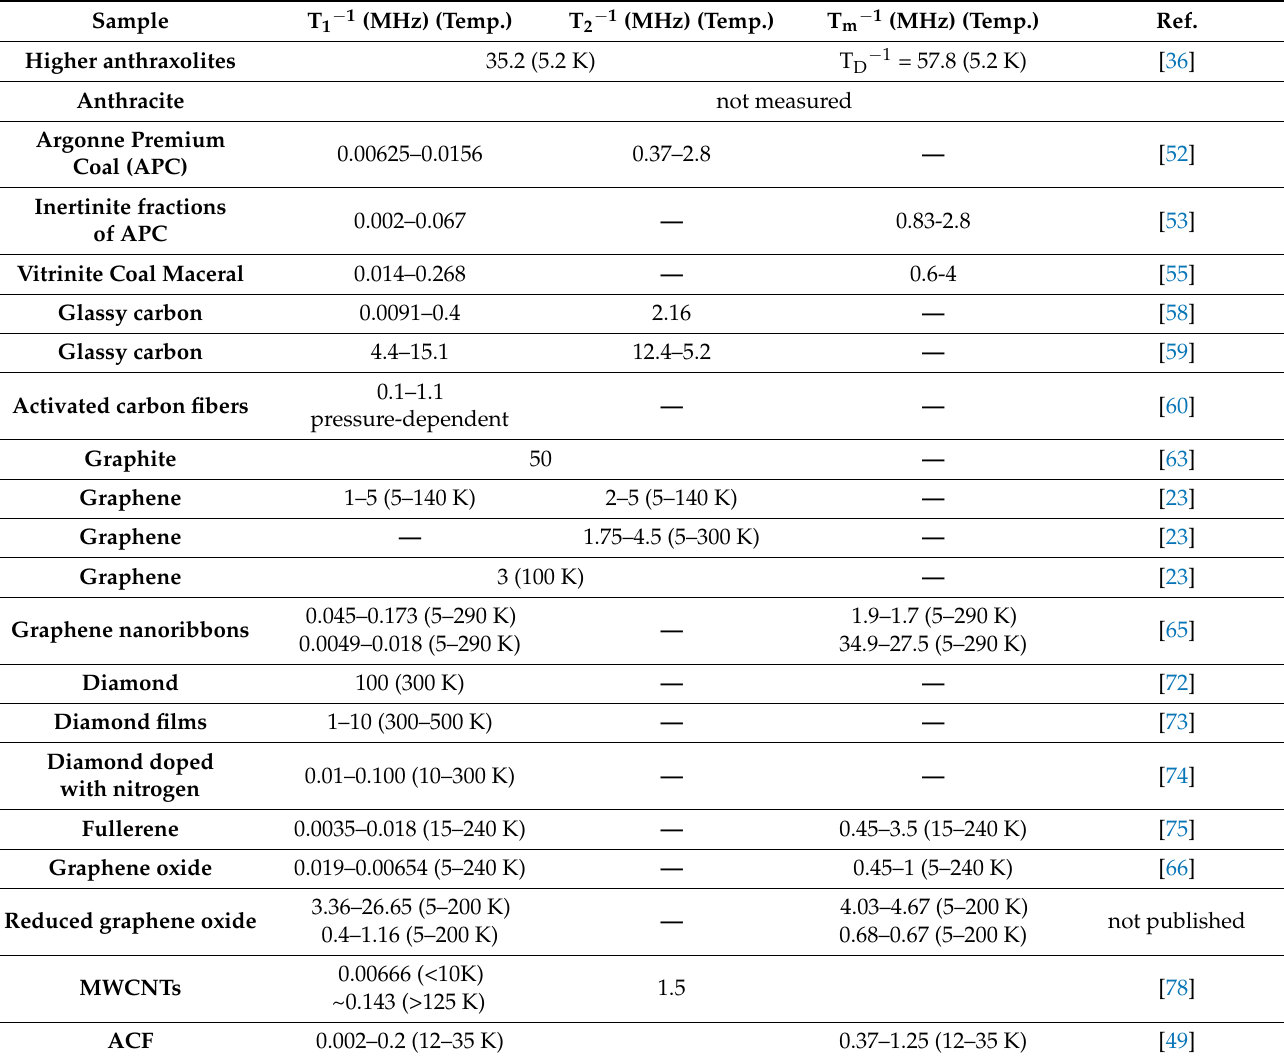
Table 1. Electron spin–lattice, spin–spin, diffusion, and phase memory relaxation rates for different carbon